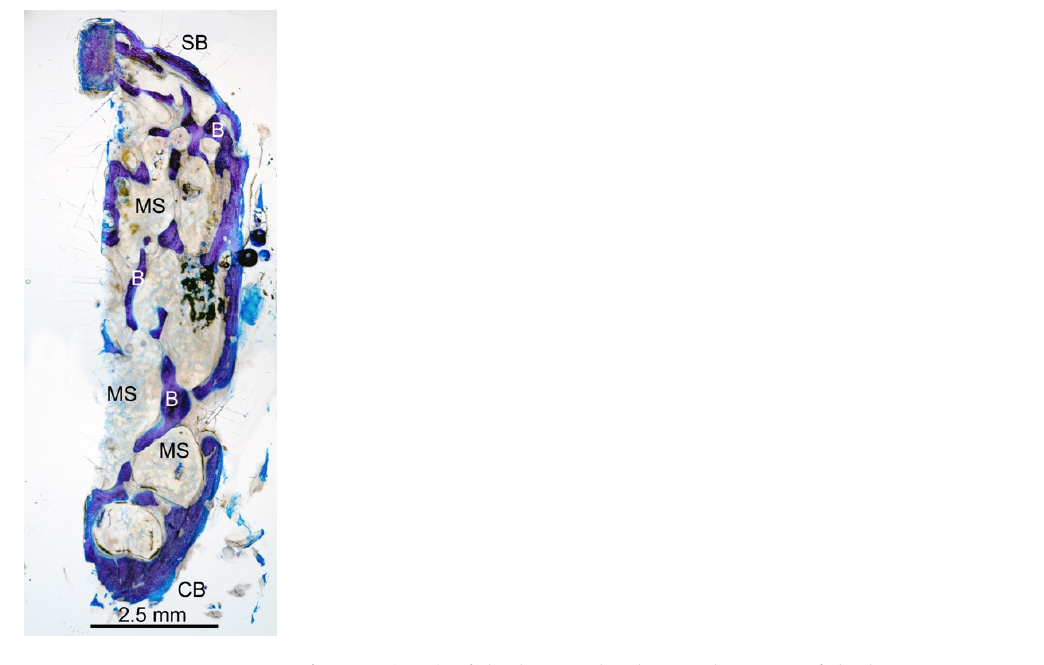
Figure 4. Low-power magnification (12×) of the longitudinal central section of the bone core. A fine trabecular bone network (B) and distributed marrow spaces (MS) were seen. Small remnants of biomaterial were present. (CB) crestal bone; (SB) sinus bone; azure B–methylene blue staining was used.